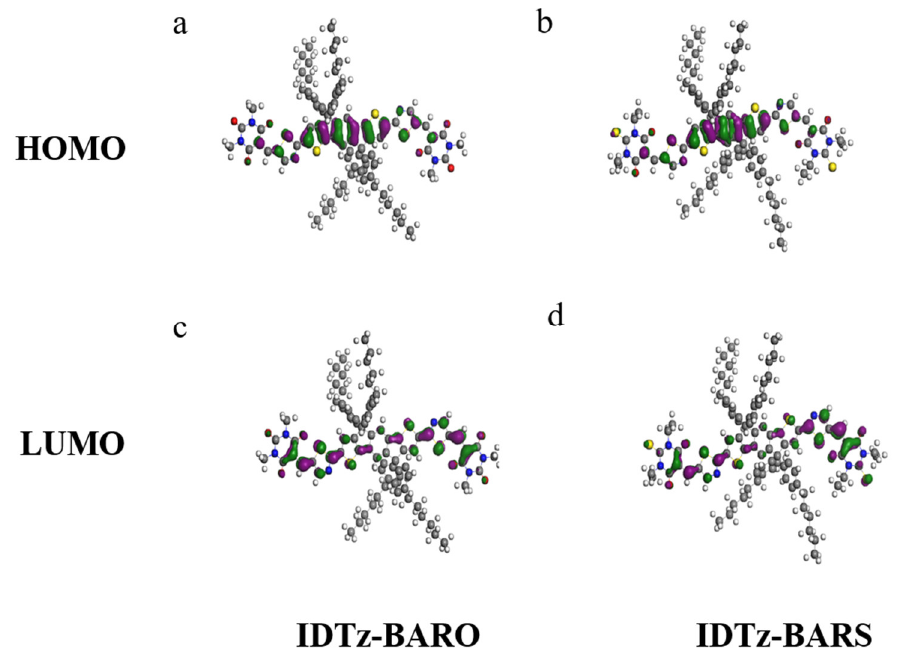
Figure 3. DFT calculation of HOMO energy levels of IDTz-BARO and IDTz-BARS ( a , b ). DFT calculation of LUMO energy levels of IDTz-BARO and IDTz-BARS ( c , d ).